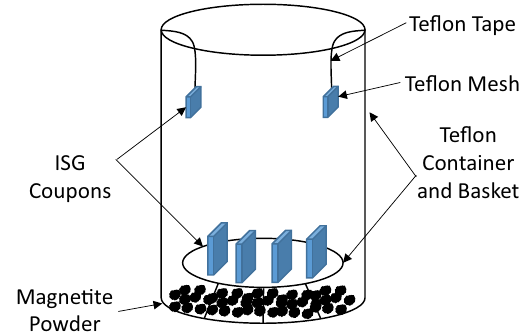
Fig. 12 Schematic of experimental set — up. Magnetite powder was added into the vessel at day